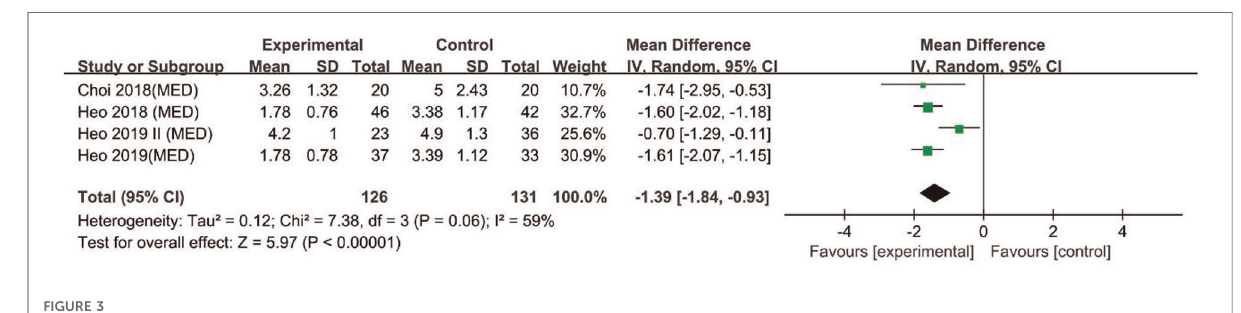
FIGURE 3 Forrest plot of vas back pain 1-day UBE vs